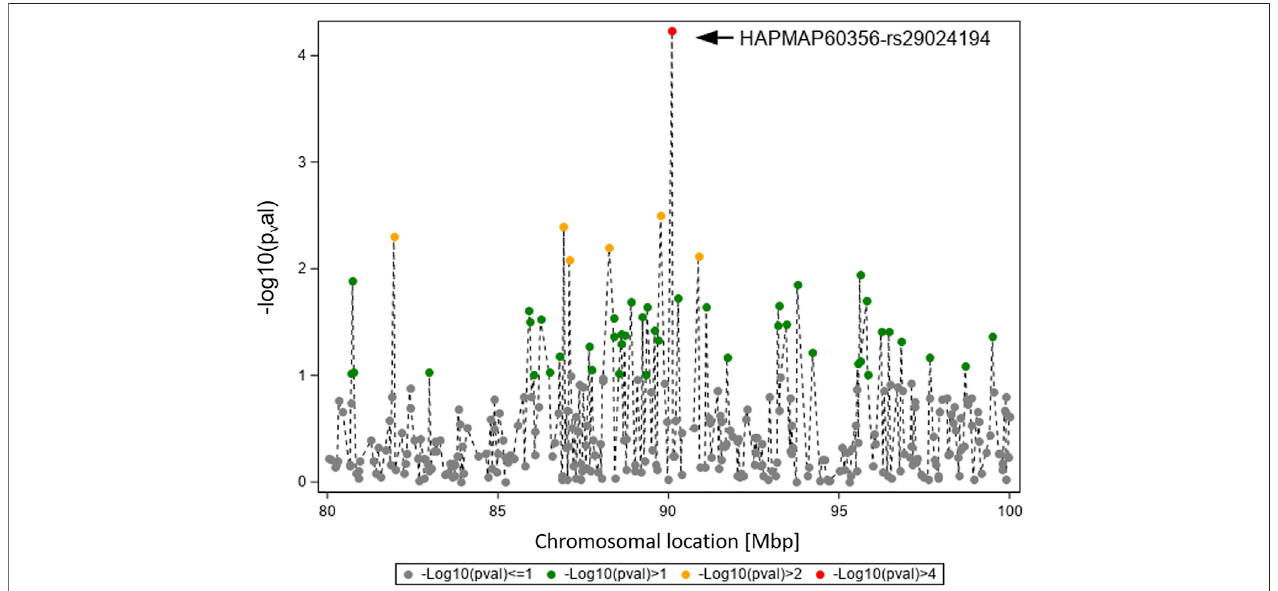
FIGURE 3 | Overview of the chromosomal region around HAPMAP60356-rs29024194 on BTA11 for trait TBIN. The -log10 p -values of detected SNP are shown. The strongest effect could be calculated for SNP HAPMAP60356-rs29024194 (black arrowhead). In general, SNP with p -values < 1.5 and SNP with SNP-genotypes < 100 animals for the rarer homozygous genotype are not displayed.